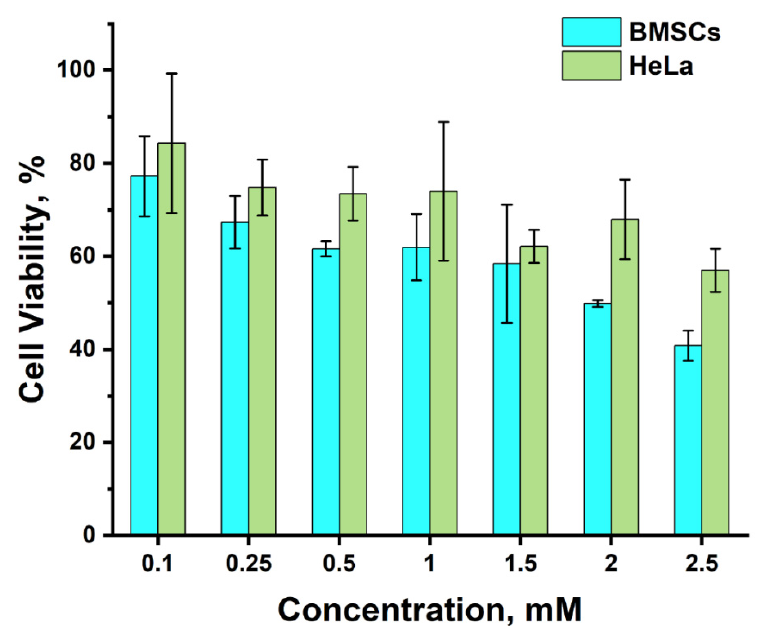
Figure 8. Cytotoxicity of Au NPs using both BMSCs and HeLa cells.